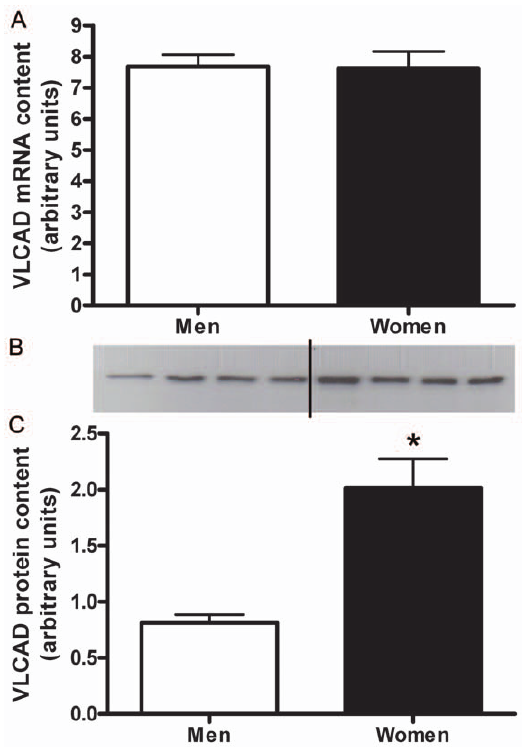
Figure 1. VLCAD protein content is higher in women than men. Differences in VLCAD mRNA content between men and women shown by Real time RT-PCR, adjusted to b 2-M mRNA (A). Protein content of VLCAD in skeletal muscle of men and women, adjusted to CS (B,C). Representative western blot (B) Lanes 1–4 are men, lanes 5–8 women. N=12 men and 11 women. *P # 0.05.